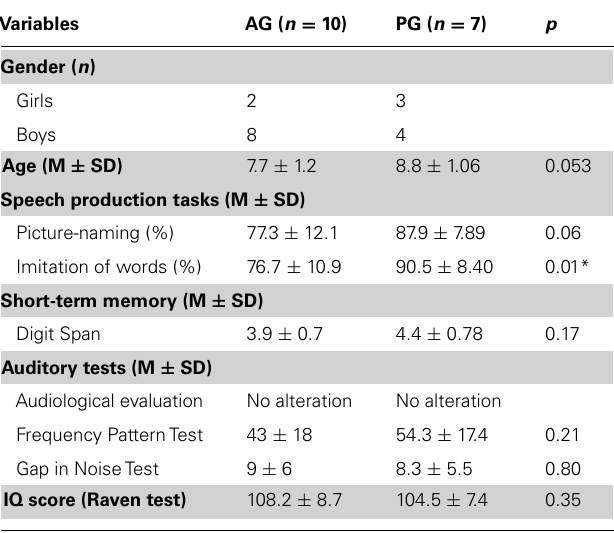
Table 1 | Performance characteristics of theAG and PG on the screening